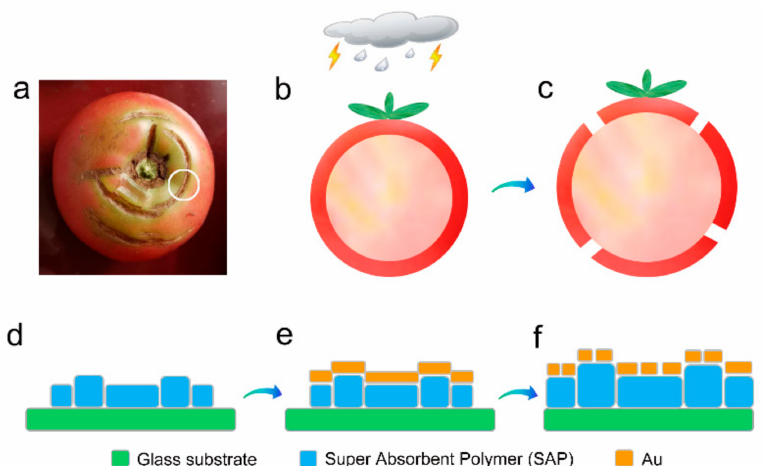
Figure 1. ( a ) Cracks on the tomato skin after raining (marked with the white circle). ( b , c ) Simple formation mechanism of the cracks on the tomato skin. ( d – f ) Schematic diagram of the water- swelling-driven route to fabricate Au